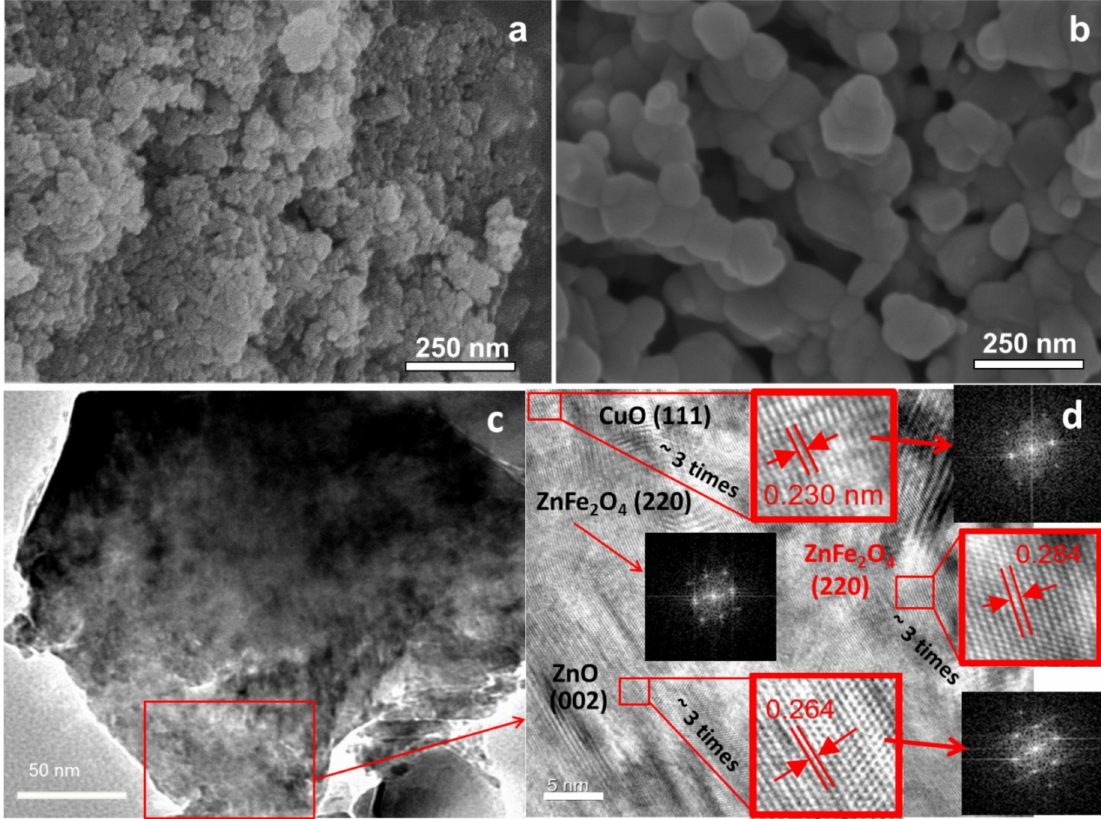
Figure 2. FE-SEM images of ( a ) the precursor of ZnO/CuO/ZnFe 2 O 4 nanocomposite and ( b ) ZnO/CuO/ZnFe 2 O 4 nanocomposite; ( c ) TEM and ( d ) HR-TEM images of the ZnO/CuO/ZnFe 2 O 4 nanocomposite. The insets in ( d ) show the magnified images and Fourier transform electron diffraction (FTED) patterns for the corresponding